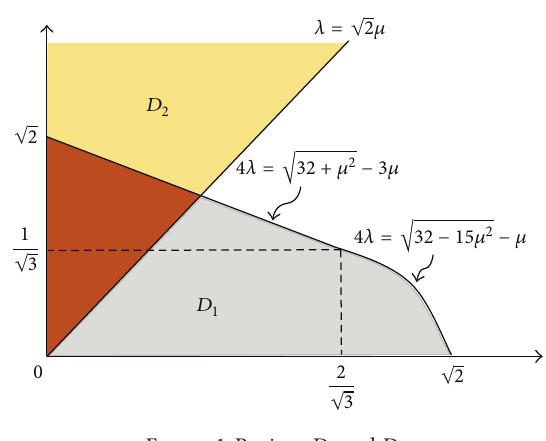
Figure 1: Regions 𝐷 1 and 𝐷 2